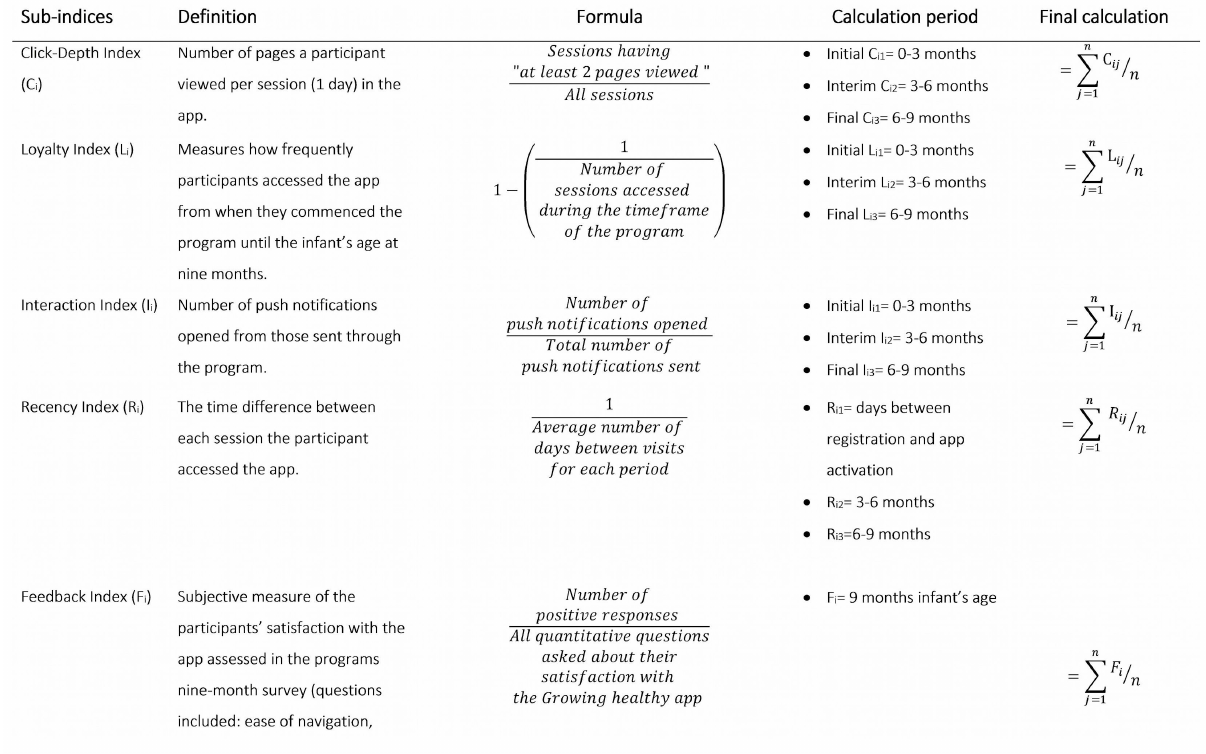
Figure 1. The definitions of the subindices for the engagement index designed for the Growing healthy program where i=ith person and j=jth time period and n=3 for Ci, Li, Ii, and Ri (sum of calculation period) and n=37 for